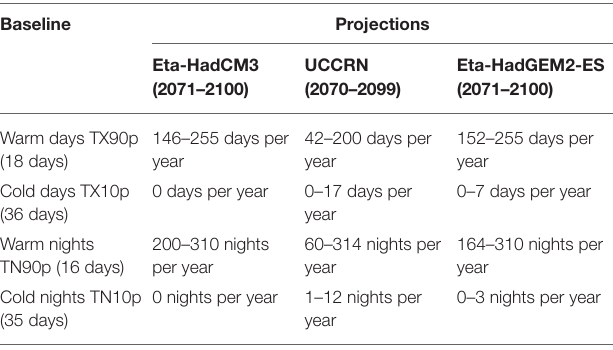
TABLE 7 | Comparison of daytime temperature extreme projections by the end of the 21st century.